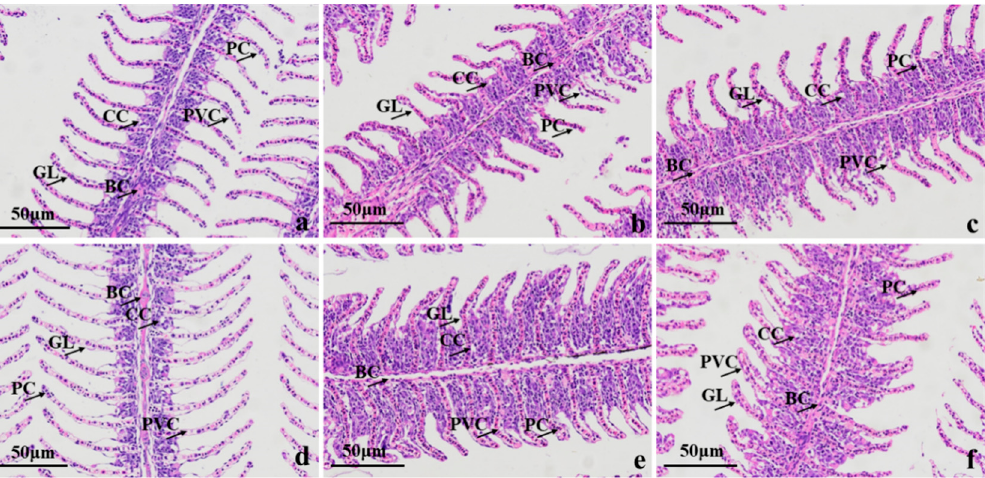
Figure 7. H&E-stained crucian carp gill tissue sections of ( a ) control group; ( b – f ) vanillin treatments at 0.50, 0.75, 1.00, 1.25, and 1.50 mg/L, respectively. Note: BC: blood corpuscle; CC: chlorine cells; GL: gill lamellae; PC: column cells; PVC: flat epithelial cells.